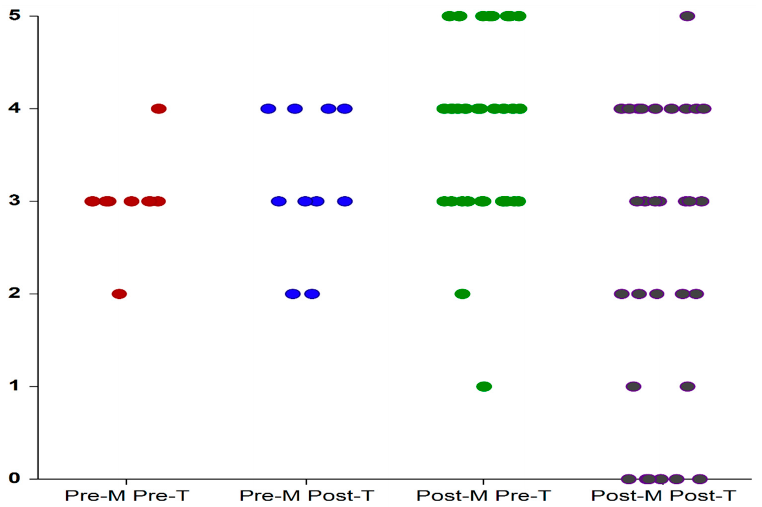
Figure 1. GPFSB3 score before treatment (Pre-T) and after treatment (Post-T) with local estrogens in patients with OAB of premenopausal (Pre-M) and post-menopausal (Post-M) onset. Each dot depicts an individual patient. T: treatment; M: menopause.